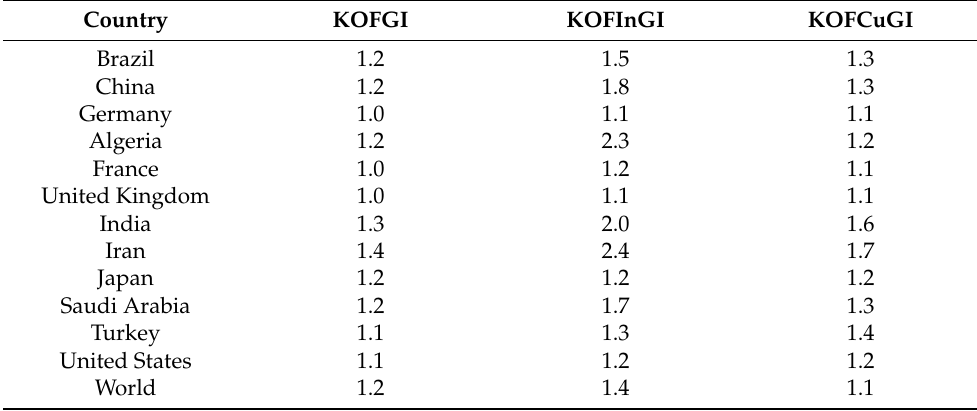
Table 4. Change of the KOFGI index and KOFInGI and KOFCuGI subindices in specific countries with different cultural traditions between 2000 to